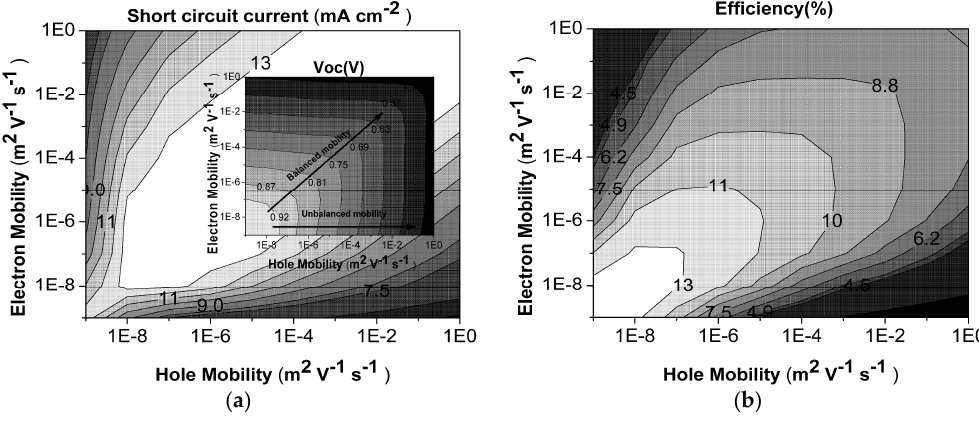
Figure 5. Counter plot showing ( a ) J sc , open circuit voltage ( V oc ) and ( b ) ultimate PCE of OSC in a wide range of electron and hole charge carrier mobility variation for efficient morphology (low reduction-induced factor).